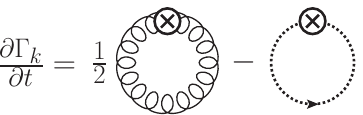
Figure 1: Flow equation. Wiggly and dotted lines represent the dressed gluon and ghost propagators, respectively. The crossed circles denote regulator insertions ∂ see